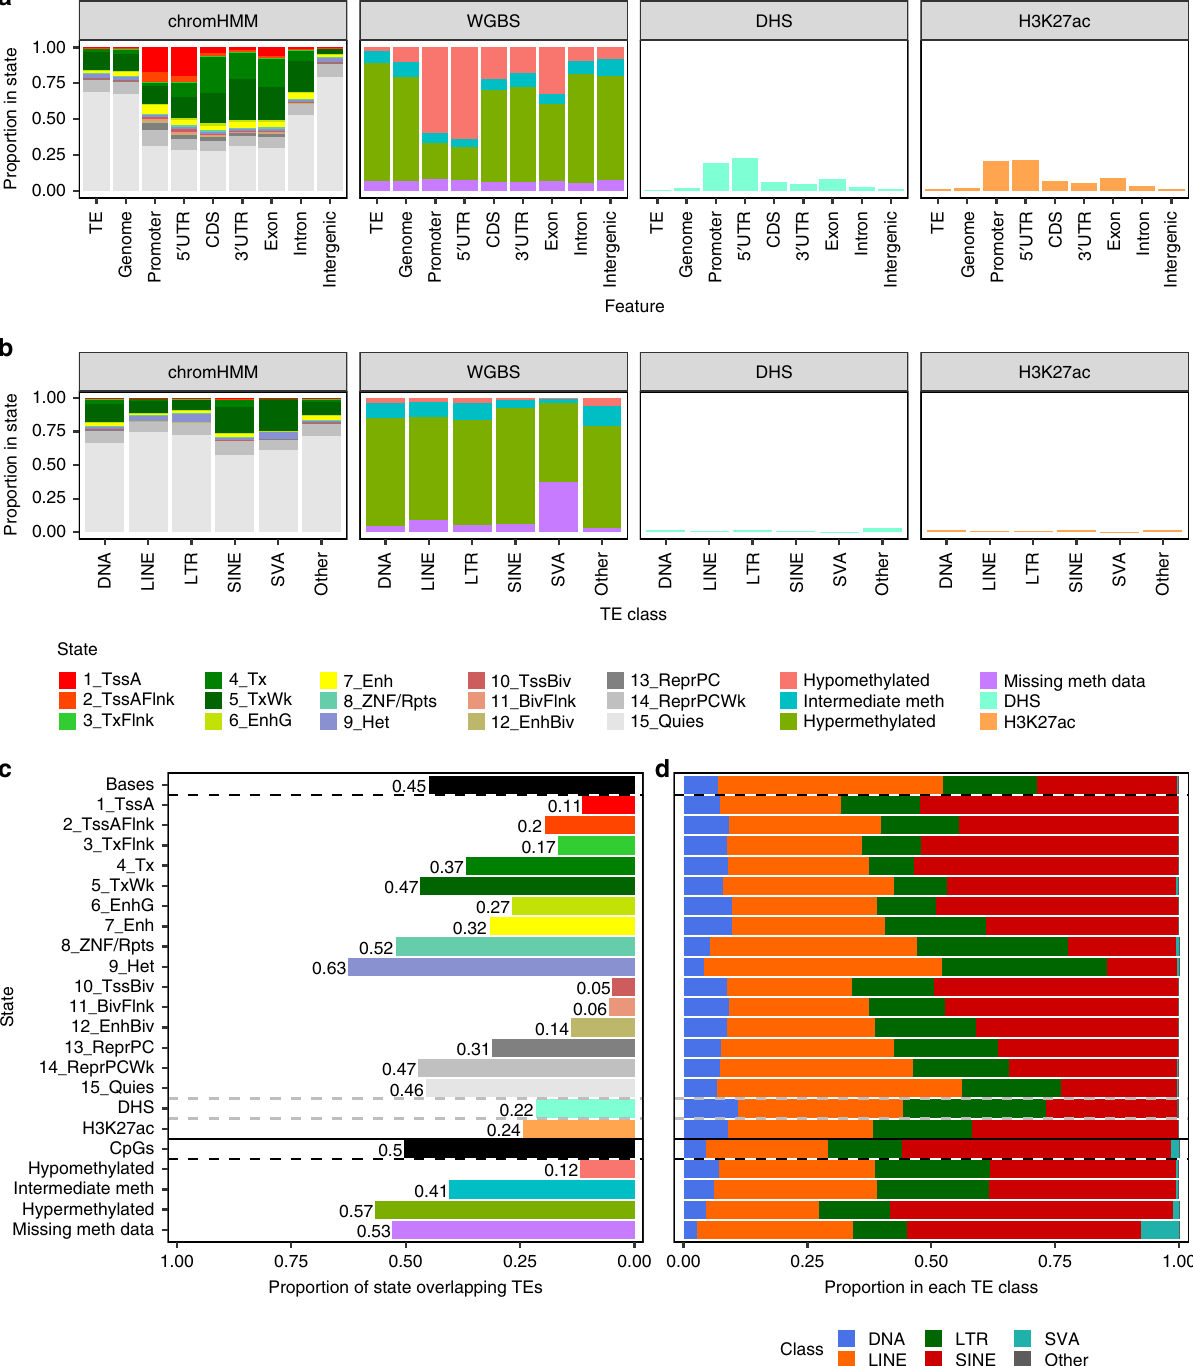
Fig. 1 Contribution of TEs to epigenetic states across all Roadmap epigenomes. a Proportion of bases within TEs, the entire genome, and RefSeq genic features annotated with each chromHMM state, methylation state (proportion of CpGs), and overlapping DHS or H3K27ac peaks, summed across all epigenomes with data for that technique (chromHMM states 127 epigenomes, methylation states 37, DHS 53, and H3K27ac 98). The color legend is below b . Methylation states are de fi ned as: hypomethylated, <30% methylated; intermediately methylated, 30 – 70%; hypermethylated, >70%; missing methylation data, ≤ 3 reads covering the CpG. CDS: coding exon; UTR: untranslated region. c Proportion of bases within each TE class annotated with each epigenetic state, summed across all epigenomes with data for that technique. c Total proportion of the epigenetic state within TEs across all epigenomes with data for that technique vs. the total proportion of all genomic bases and CpGs within TEs. Bars are colored by state ( y -axis). d The proportion of each bar in c by TE class. The y -axis is shared with c